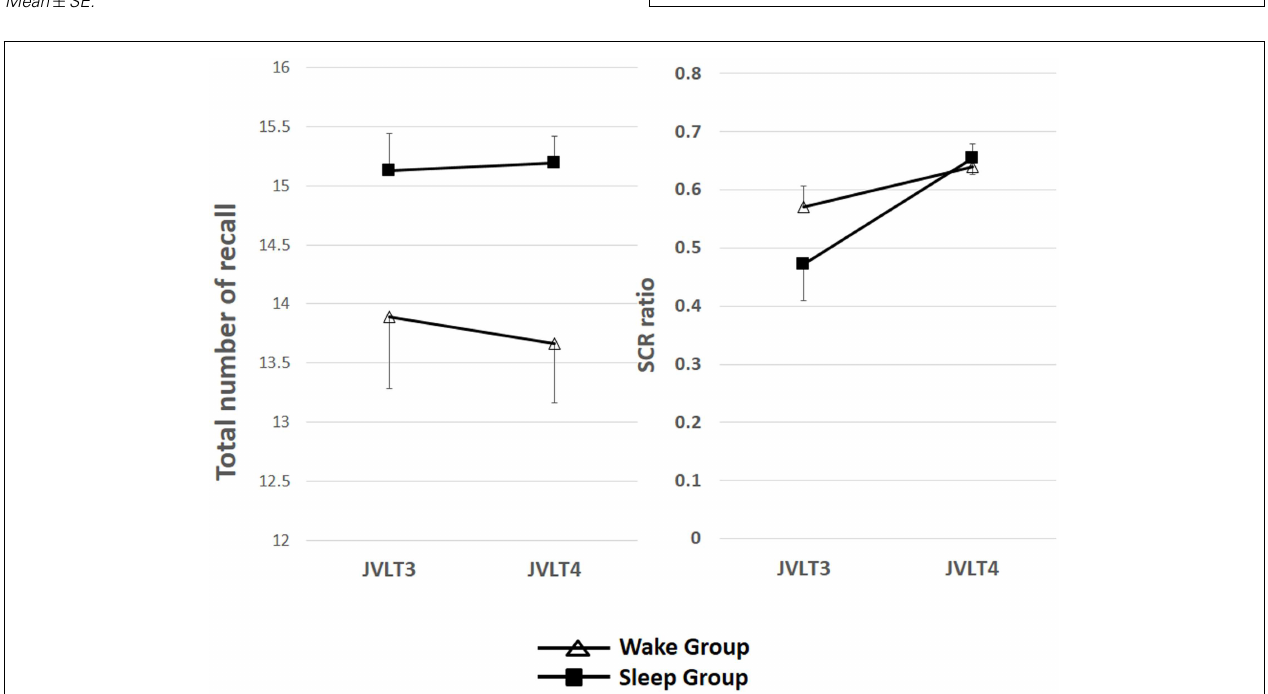
was not observed [ F (1, 32) = 0.82, p = 0.78].Time × Group interaction was not significant for the SCR ratio [ F (1, 32) = 2.77, p = 0.11], although a significant main effect ofTime was observed [ F (1, 32) = 13.2, p = 0.01].The error bars represent standard error of the